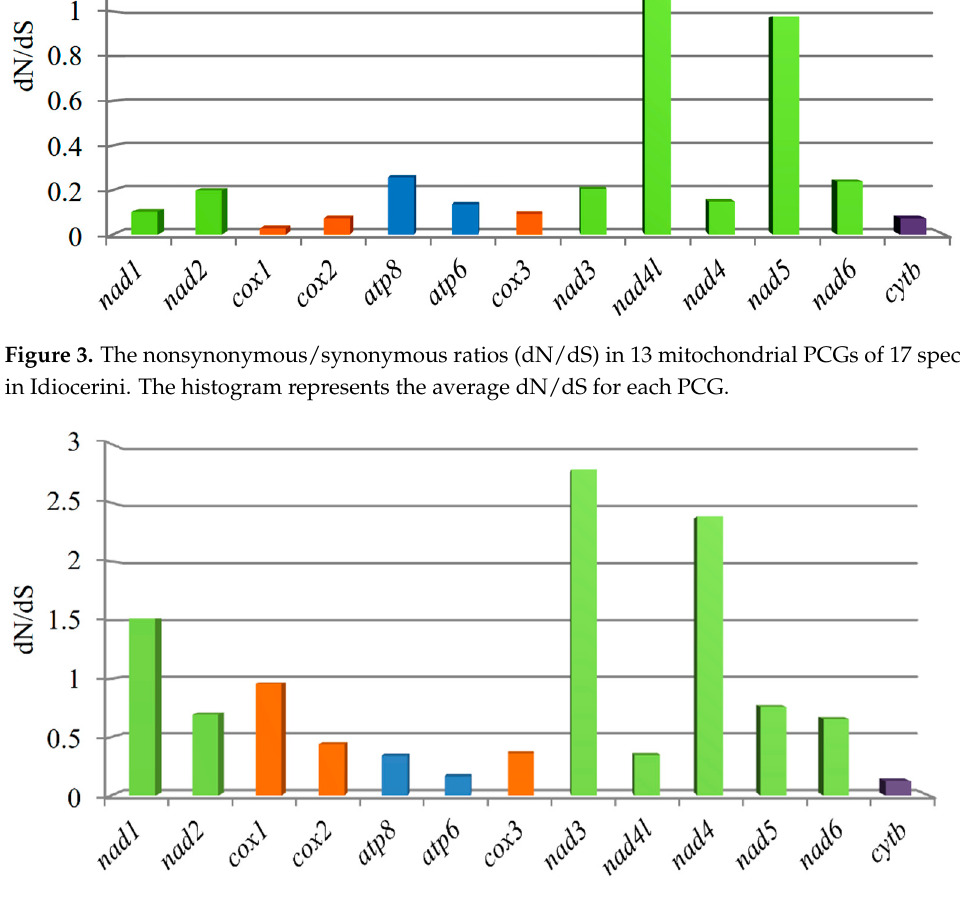
Figure 4. The nonsynonymous/synonymous ratios (dN/dS) in 13 mitochondrial PCGs of 167 species in Cicadellidae. The histogram represents the average dN/dS for each PCG.